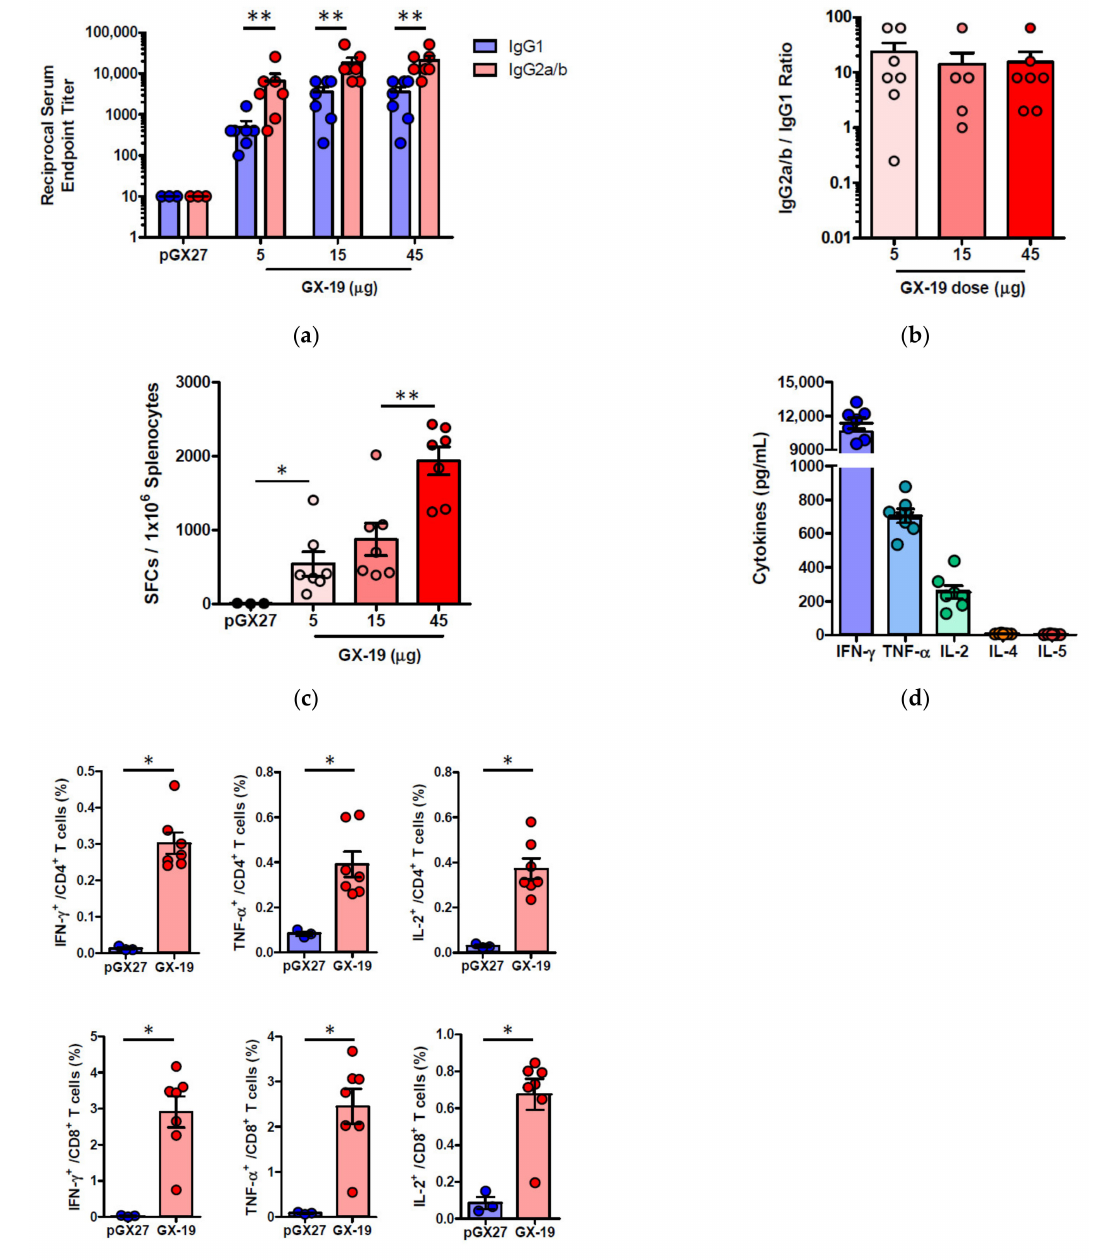
Figure 3. Immunization with GX-19 elicits Th1-biased T cell responses in mice. BALB/c mice ( n = 3–7/group) were immunized at weeks 0 and 2 with indicated doses of GX-19 or pGX27 (empty control vector) as described in the Methods ( a – c ). Sera were collected at 2 weeks post-boost and assessed for SARS-CoV-2 S-specific IgG1 and IgG2a/b. Endpoint titers ( a ), and endpoint tier ratios of IgG2a/b to IgG1 ( b ) were calculated. At 2 weeks post-boost, mouse splenocytes were isolated and re-stimulated with peptide pools spanning the SARS-CoV-2 S protein ex vivo. Indicated cytokines in the supernatants of culture were quantified using a Th1/Th2 cytometric bead array kit. Mean value of the medium alone background (mean ± s.d., pg mL − 1 ) was 19.17 ± 8.61 for IFN- γ , 57.12 ± 6.53 for TNF- α , 33.10 ± 6.72 for IL-2, 7.83 ± 0.45 for IL-4, and 4.66 ± 0.13 for IL-5 ( d ). T cell responses were measured by IFN- γ ELISPOT in splenocytes stimulated with peptide pools spanning the SARS-CoV-2 S protein. Shown are spot-forming cells (SFC) per 10 6 splenocytes ( c ). Cells were stained for intracellular production of IFN- γ , TNF- α , and IL-2. Shown are the frequency of S-specific CD4 + or CD8 + T cells after subtraction of background (DMSO vehicle, Sigma-Aldrich, St. Louis, MO, USA) ( e ). Data representative of two independent experiments. All data are represented as individual values. * p < 0.05, ** p < 0.01 as determined by the Mann–Whitney